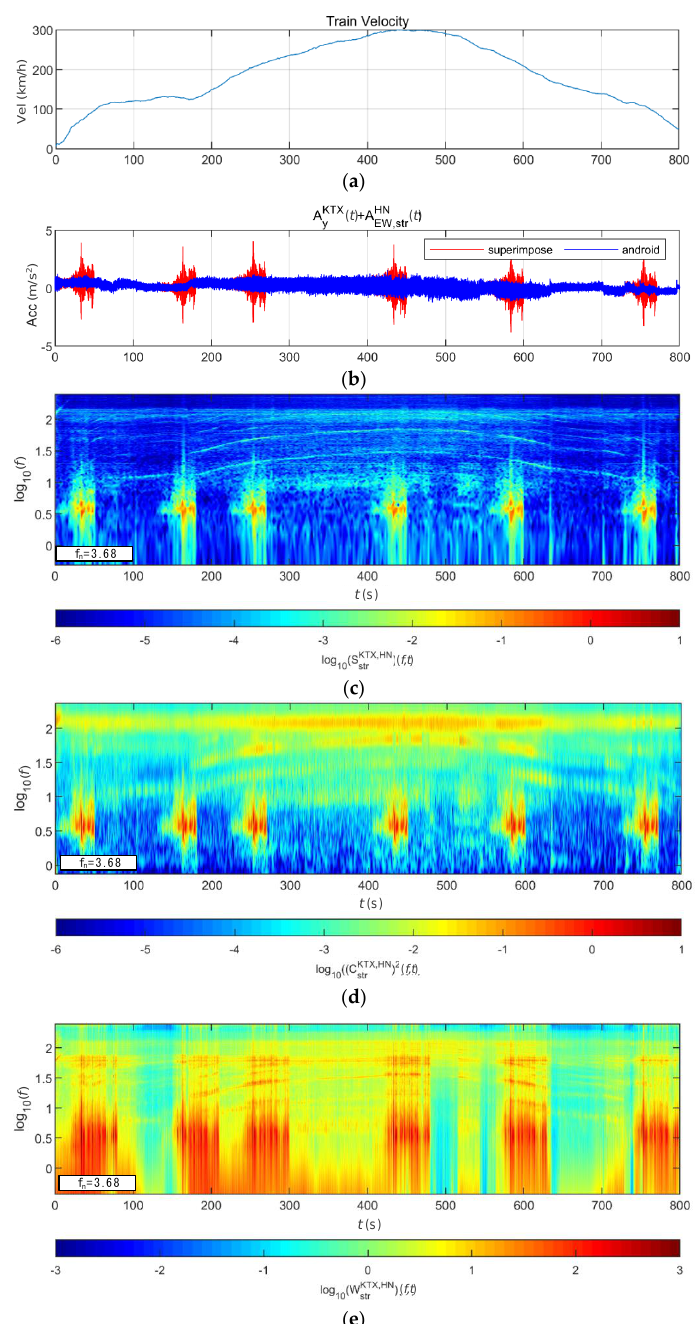
Figure 38. Combination of train data with BR3 bridge-response data from the Hachinohe earthquake (scaled to 1000-year return period): ( a ) velocity; ( b ) lateral acceleration time series; ( c ) STFT; ( d ) WT; ( e ) WVD.